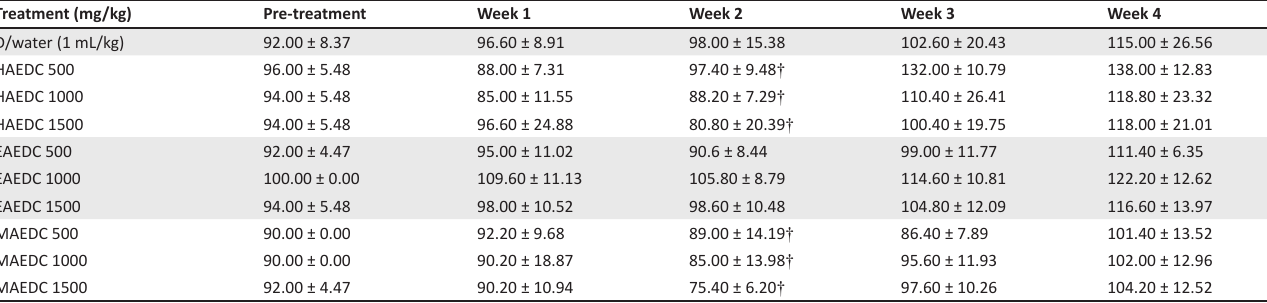
TABLE 1: Effects of n -hexane, ethyl acetate and methanol extracts of Daucus carota aerial part on the body weights (g) of Wistar rats after oral administration for 28 days. Treatment (mg/kg)